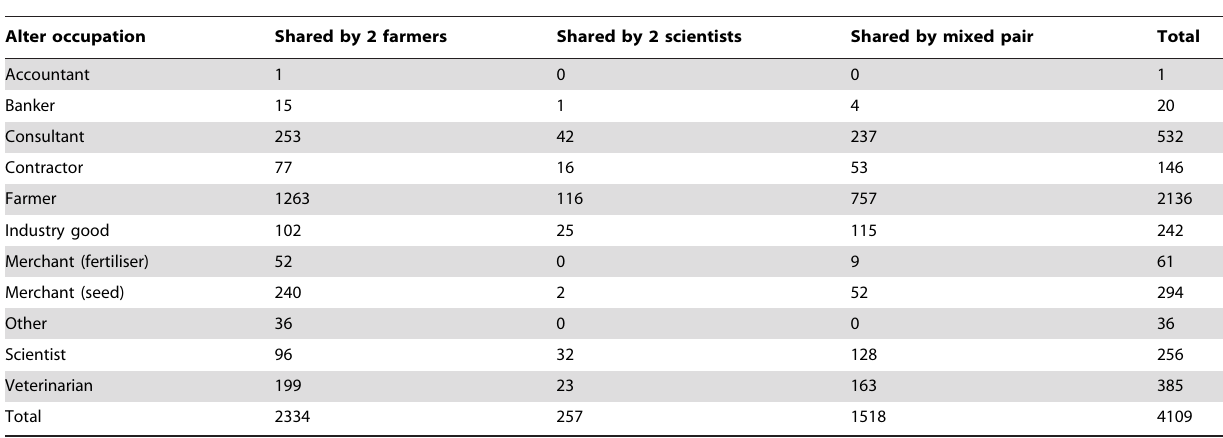
Table 3. Group contact sharing by triadic form and alter